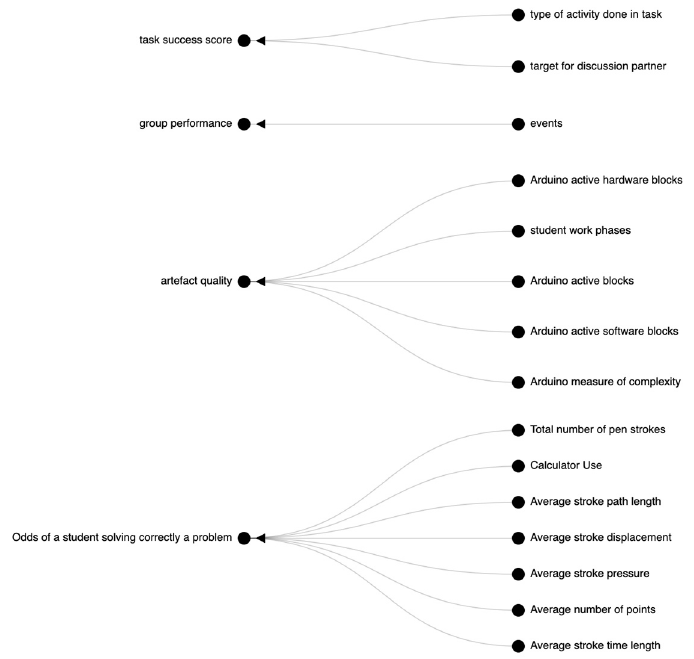
Figure 5. After clicking on the edge between “Log Data” and “Performance”, users can explore the outcomes and measures used to connect the two. By further clicking on the nodes, users can open the actual paper on Google Scholar.